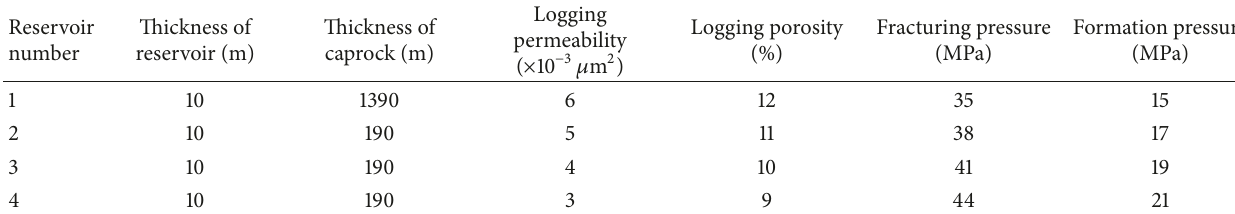
Table 3: Characteristic parameters of the reservoirs in the conceptual engineering